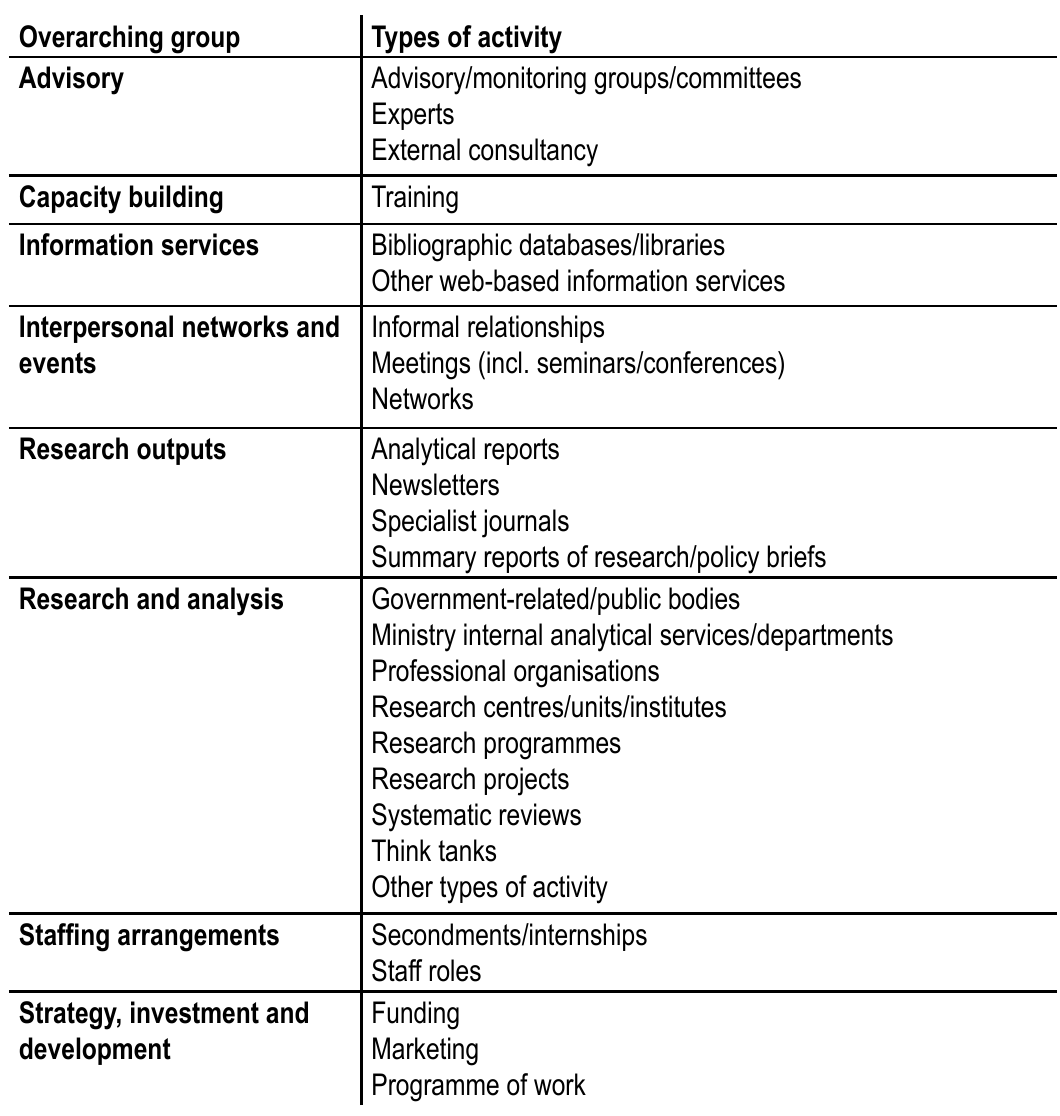
Table 1: Types of activity and their overarching